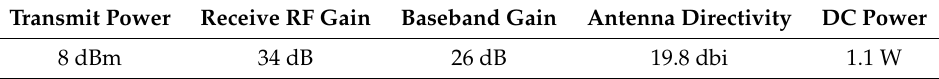
Table 1. Key parameters of the